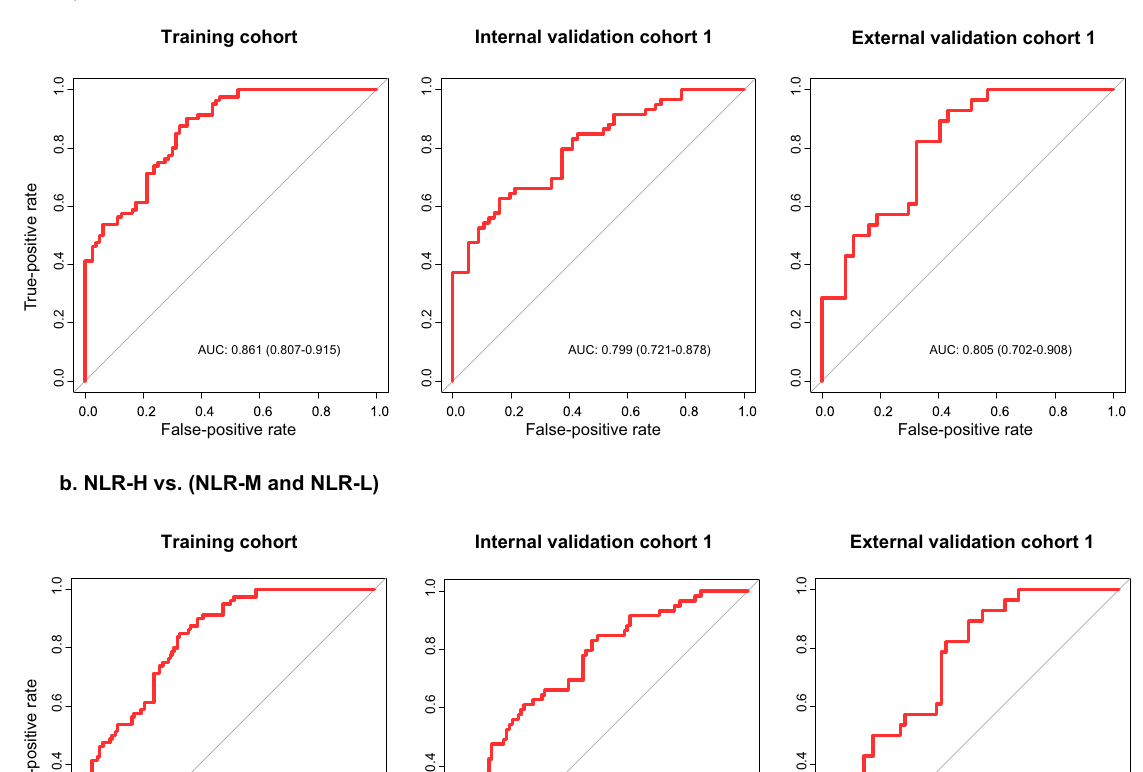
the training cohort (NLR-L: n =80; NLR-M: n =80; NLR-H: n =80), internal valida- tion cohort 1 (NLR-L: n =56; NLR-M: n =43, NLR-H: n =59), and external validation cohort1(NLR-L: n =37;NLR-M: n =27;NLR-H: n =28).Thedataarepresentedasthe mean values with SEM. For statistical comparisons among different groups, a two- tailed t test (unpaired) was used. NLR-H: NLR-High group, NLR-M: NLR-Mix group, NLR-L: NLR-Low group. Source data are provided as a Source data fi